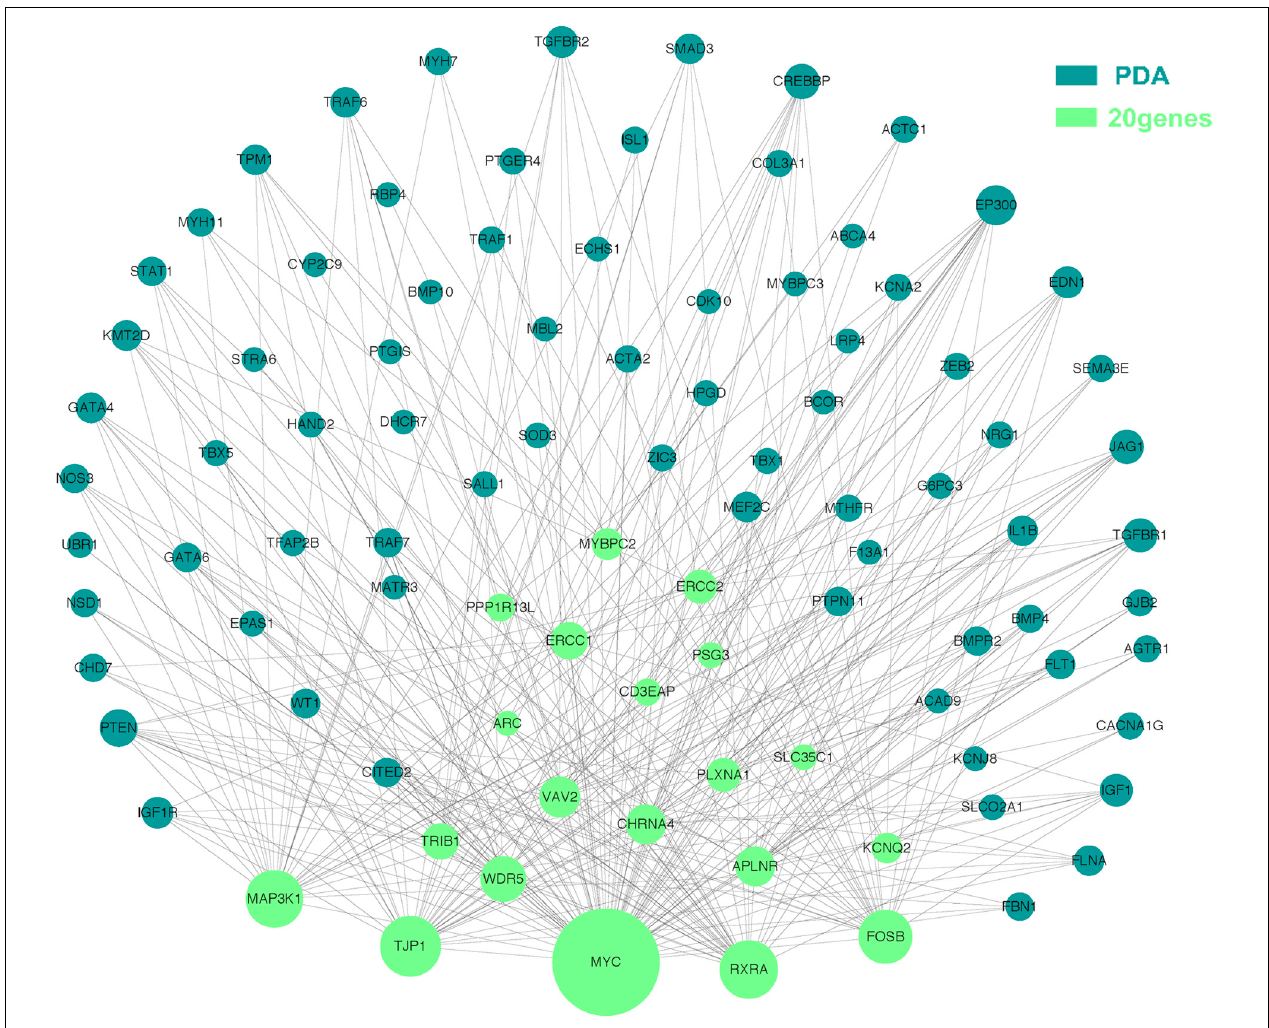
FIGURE 5 | Utilizing integrated human PPI network between 20 candidate genes and known genes associated with PDA. The green nodes represent rare CNVs loci genes in this study and the blue nodes represent the genes in list 2. The different size of the green nodes represent different intensity of the protein interaction, and the larger the green nodes, the closer the interaction